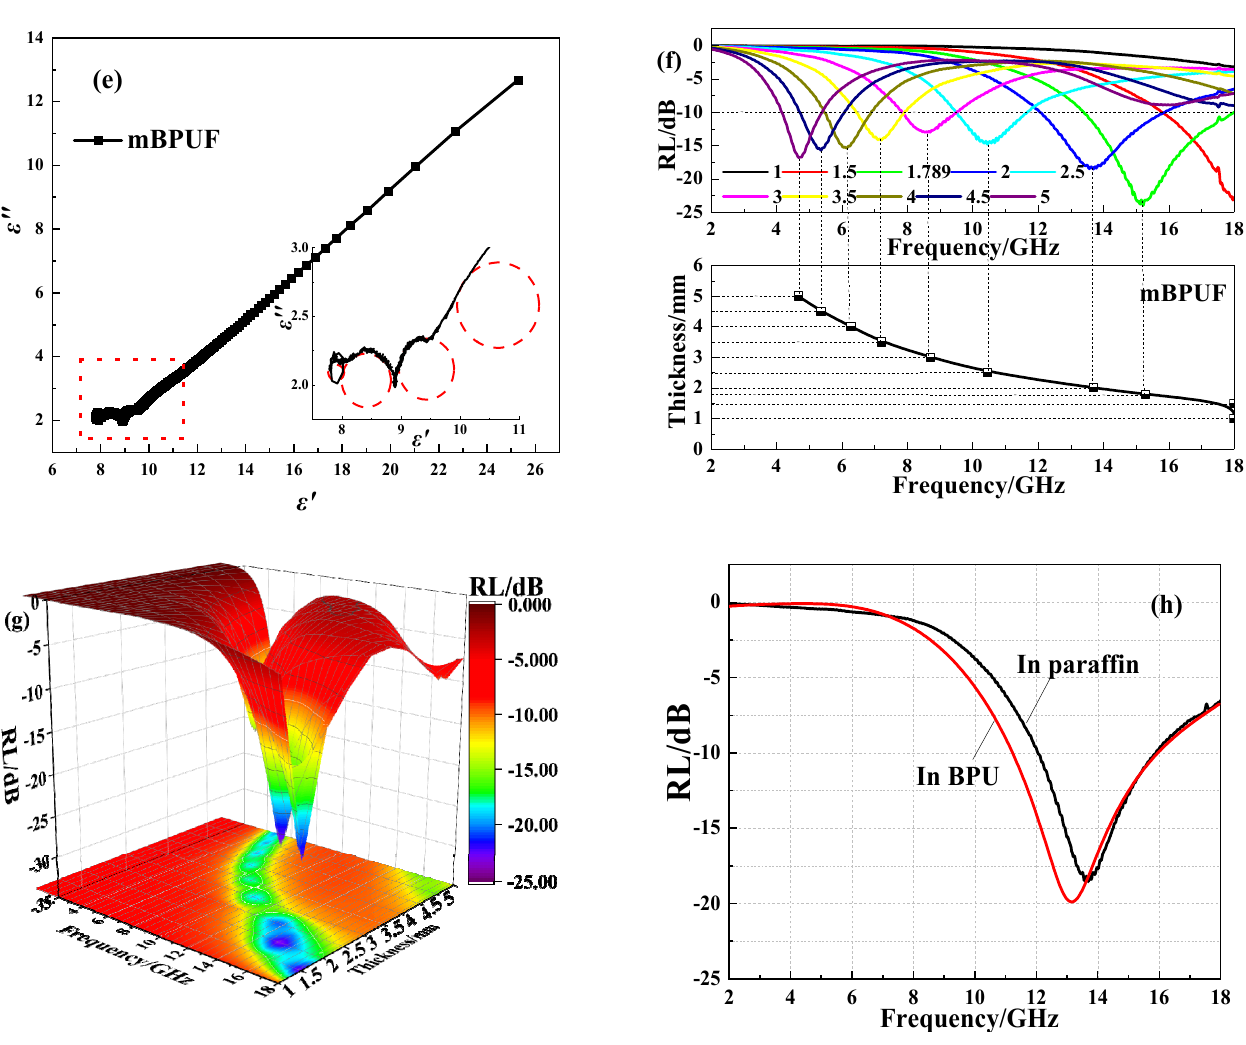
Figure 6. Graphs showing the change in ( a ) saturation magnetization curves; ( f ) reflection loss ( RL ); ( b ) magnetic tangent; ( c ) attenuation constant ( α ); ( d ) C 0 over a range of frequencies; ( e ) typical Cole–Cole semicircles for the mBPUF powders; ( g , h ) reflection loss ( RL ) for the mBPUF-f compo- sites.